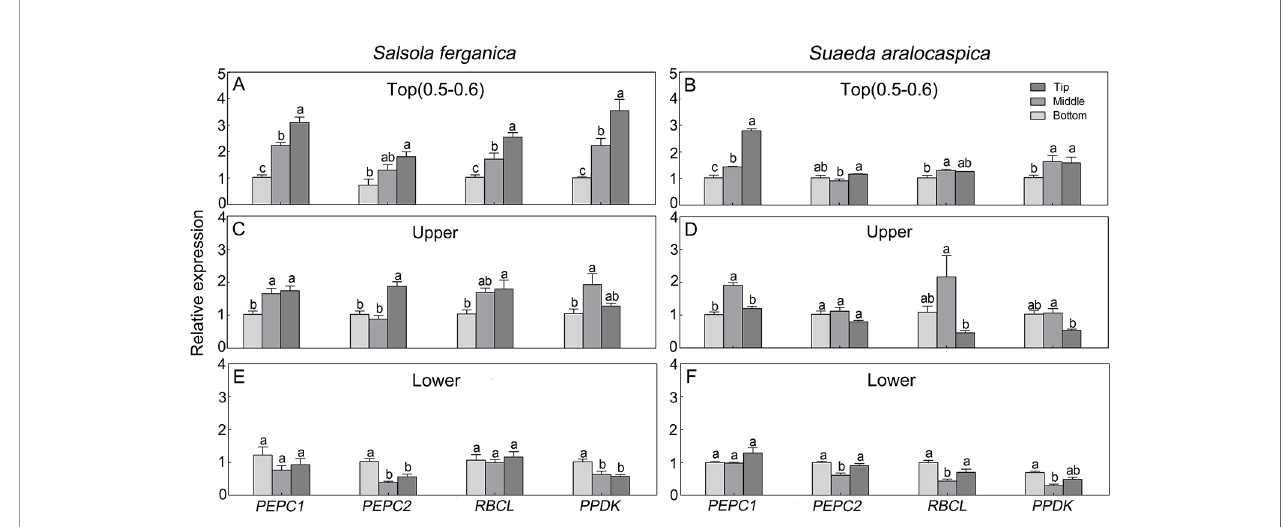
FIGURE 10 | Transcriptional expression patterns of key photosynthetic genes in leaf of different positions of plant or along longitudinal direction in S. ferganica and S. aralocaspica . (A, C, E) S. ferganica ; (B, D, F) S. aralocaspica ; (A, B) 0.5 – 0.6 cm young leaf in top of plant; (C, D) Upper part leaf of plant (1.3 – 1.5 cm leaf in B; 1.8 – 1.9 cm in E); (E, F) Lower part leaf of plant (1 cm leaf in C; 2 cm in F). Bottom, Middle, Tip: Different segments along longitudinal leaf gradient. All samples were collected from indoor plants. Relative expression level is represented as the sample transcripts subtract the reference transcripts. Different lowercase letters above columns indicate signi fi cant differences ( P < 0.05 or 0.01) of the same gene between positions in one leaf. Values are means ± SE of three biological and two technical replicates (total of six